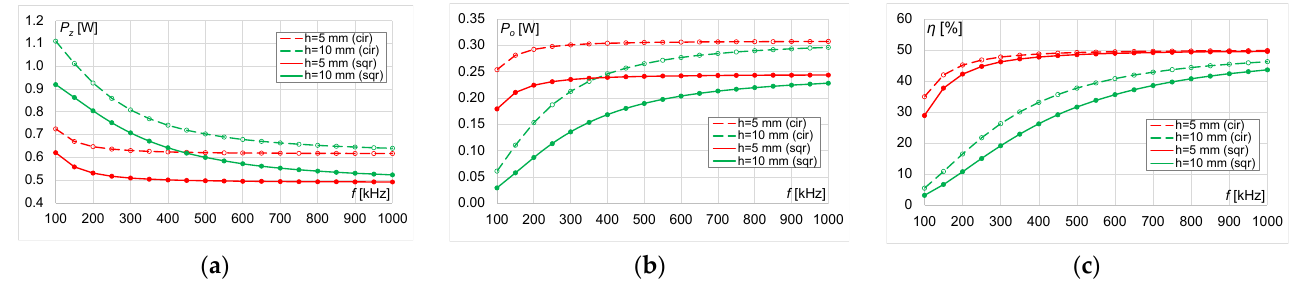
Figure 21. Results for circular and square coils with r = 10 mm and number of turns n = 35 at different distances ( h = 5 mm and h = 10 mm): ( a ) transmitter power, ( b ) receiver power and ( c ) power transfer efficiency.